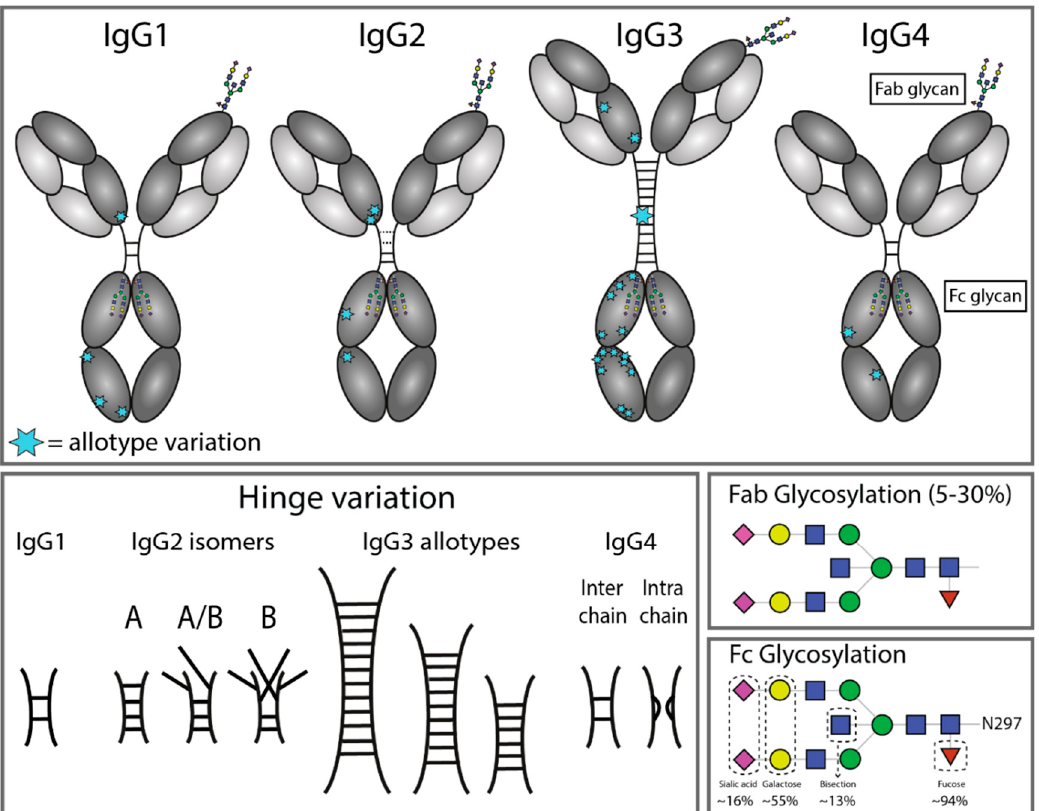
Figure 1. Structural variation of immunoglobulin G subclasses. A structural representation of the immunoglobulin G (IgG) subclasses and the variation within these subclasses, including allotype variation, hinge variation, and glycosylation. The variation originating from allotypic polymorphisms in the immunoglobulin heavy gamma (IGHG) constant domain is indicated by blue stars. Except for the star representing the variation in hinge length between IgG3 allotypes, each blue star indicates amino acid variation at one particular residue in the constant domain. Fab glycosylation is indicated and is present in 5–30% of antibodies in serum, depending on subclass and antigen specificity. The glycoform of the N297 Fc glycan is highly variable, for which the frequency of each glycan moiety on IgG antibodies in human serum is indicated.